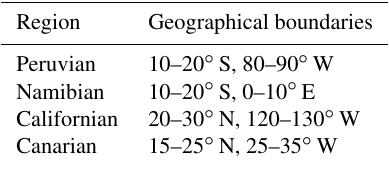
Table 1. Geographical extent of the regions used in this study. Region Geographical